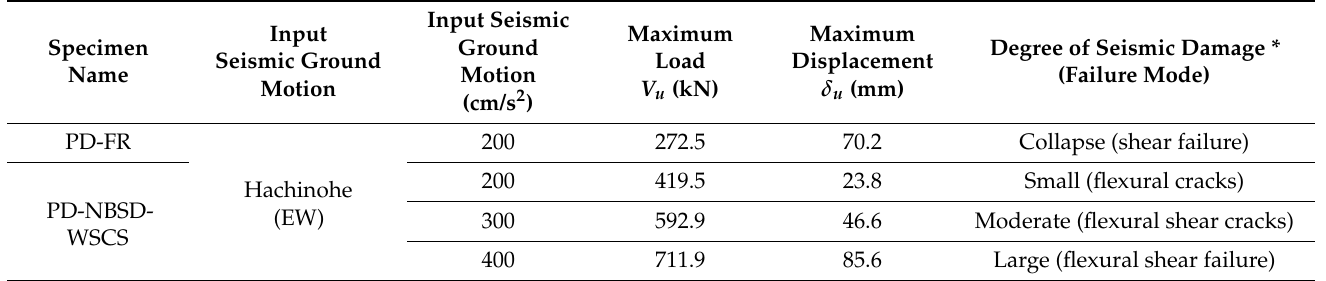
Table 9. Maximum response load-displacement and the degree of seismic